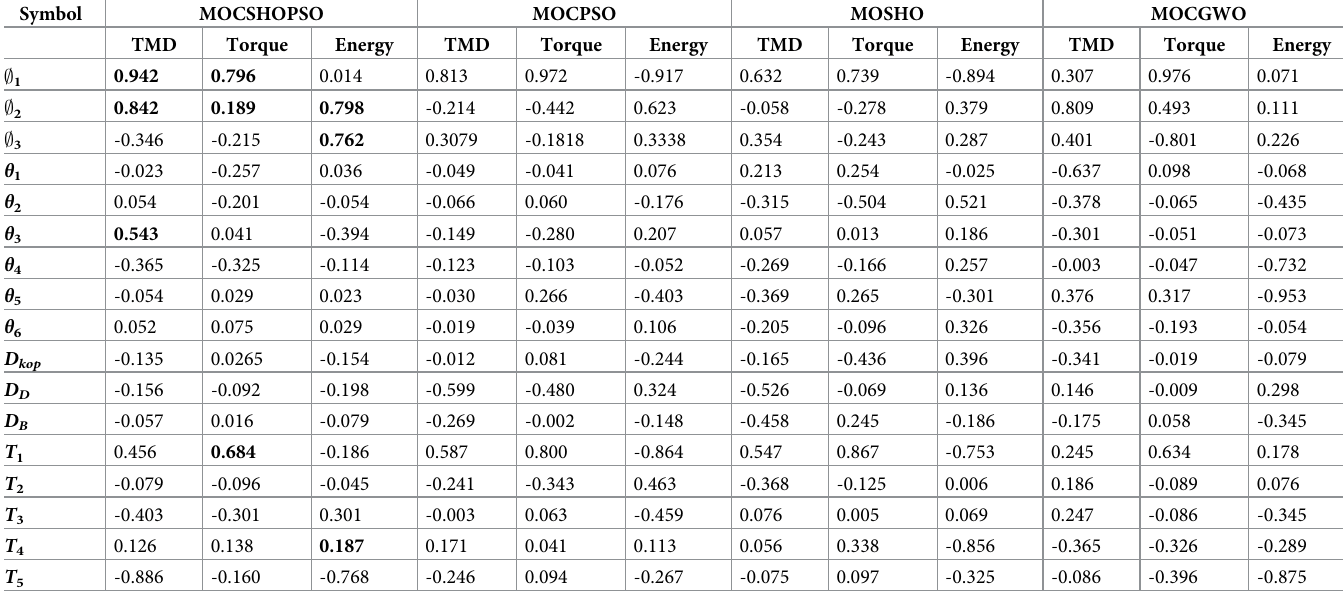
Table 10. Spearman correlation coefficient analysis for the decision